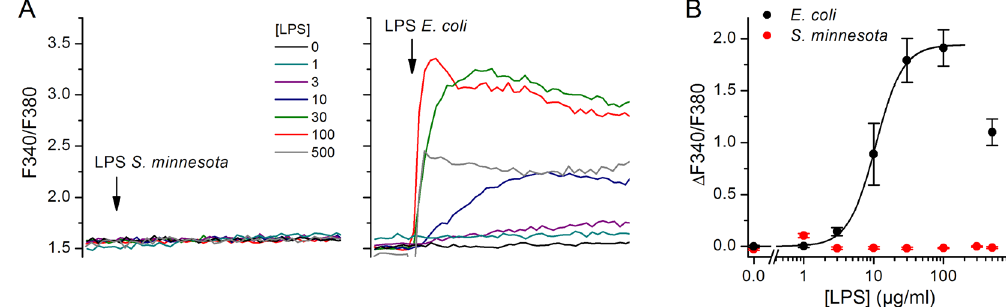
Figure 1. E . coli LPS, but not S . minnesota LPS, activates mouse TRPA1. ( A , B ) Representative traces of average intracellular Ca 2 + levels recorded in TRPA1-CHO cells in control and in the presence of LPS from S . minnesota (left panel) and E . coli (right panel). The arrows indicate the time point when LPS was applied. ( B ) Concentration dependence of the amplitude of the responses to S . minnesota and E . coli LPS. The black line represents the fit of a Hill equation to the E . coli LPS data (effective concentration = 10.6 ± 0.4 µ g/ml and Hill number = 2.2 ±